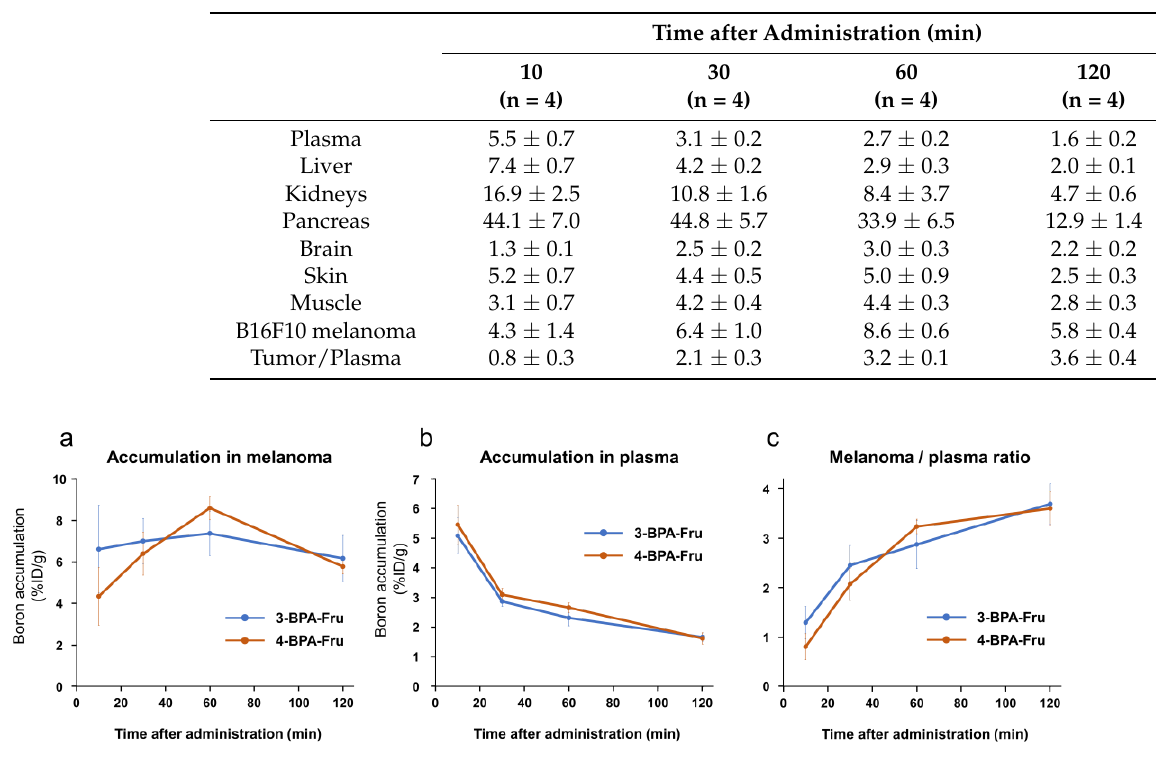
Figure 3. Boron accumulation in B16F10 melanoma ( a ) and plasma ( b ), and melanoma to plasma ratio of boron accumulation ( c ) of 3-BPA-Fru and 4-BPA-Fru at 10, 30, 60, and 120 min after administration.